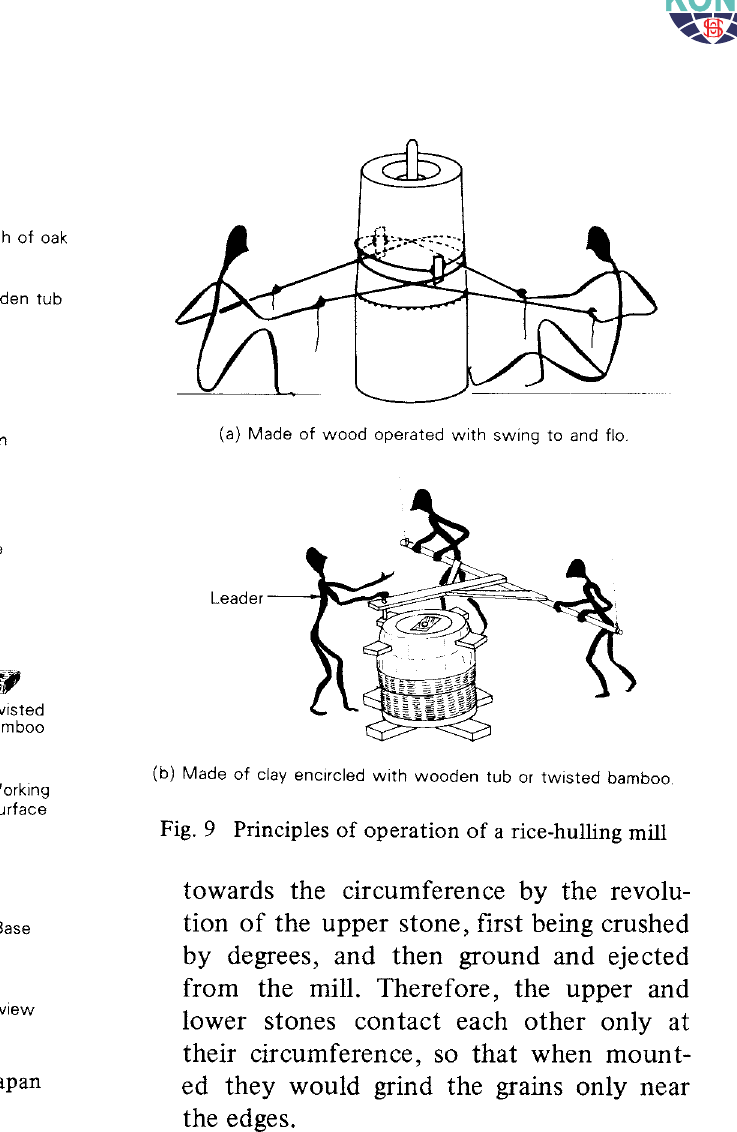
Fig. 8 An example of rice-hulling mill of Japan (Yamagata Pref.)